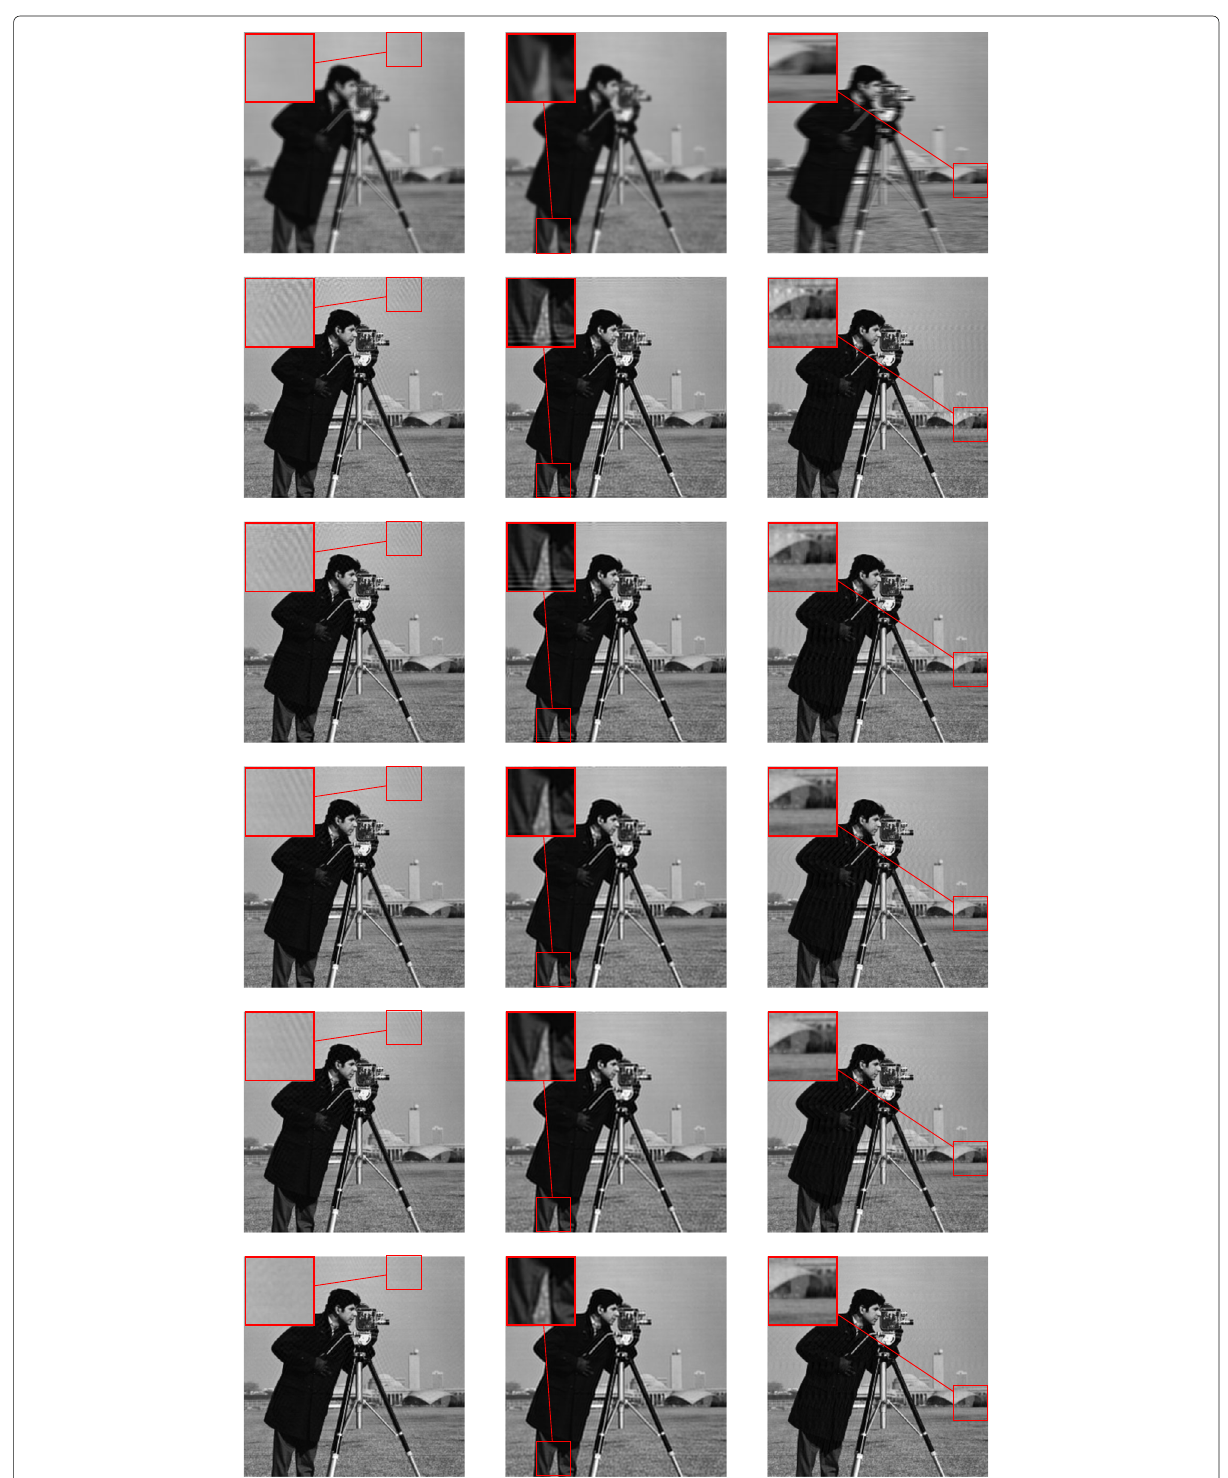
Fig. 4 Deconvolution of Cameraman image. From left to right, the first column represents degradation by kernel 1, the second column for the degradation by kernel 2, and by kernel 3 in the third column. From top to bottom, the order of the rows is as follows: blurred images using the three kernels respectively, restored images using RL algorithm [11] (kernel 1 (iterations = 90), kernel 2 (iterations = 300), and kernel 3 (iterations = 200)), restored images using Wiener filter [9], restored images using TV method [14], restored images using BTV approach [16], and finally the restored images using our proposed MAP- H 1